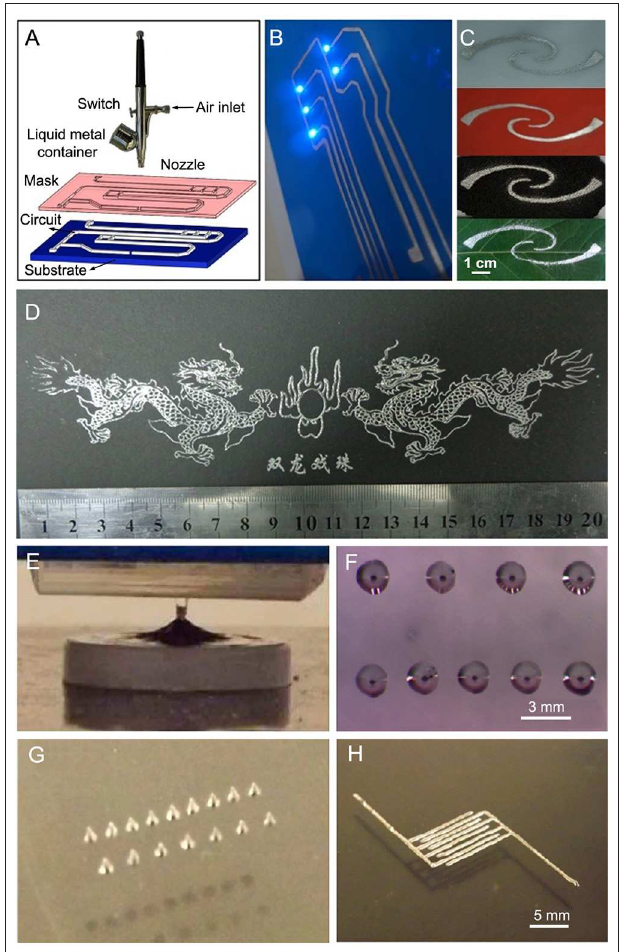
FIGURE 7 | The schematic diagram of the atomized spraying of liquid metal (A) , and a printed LED circuit (B) , and conductive tracks on the surfaces of the substrates which are PVC, typing paper, porous rubber, and tree leaf, from top to bottom, respectively (C) . A picture of two dragons playing with a pearl pattern printed on black paper substrate (D) . Reproduced with permissions from Zhang et al. (2013). Copyright 2013, Springer Nature. Reproduced with permissions from Wang and Liu (2015b). Copyright 2015, Royal Society of Chemistry. The image of the tip of the print head contacting the liquid metal ink (E) , and the printed 340- µ m-diameter liquid metal droplets arranged on a silicone elastomer substrate (F,G) , and a printed comb capacitor (H) .